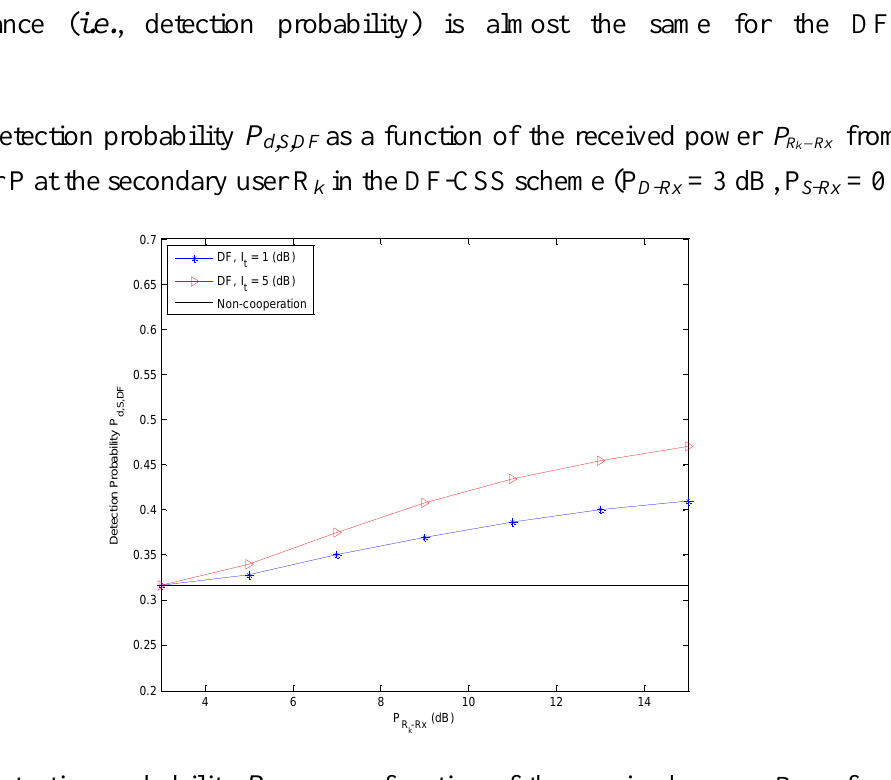
Figure 3. Detection probability P primary user P at the secondary user R